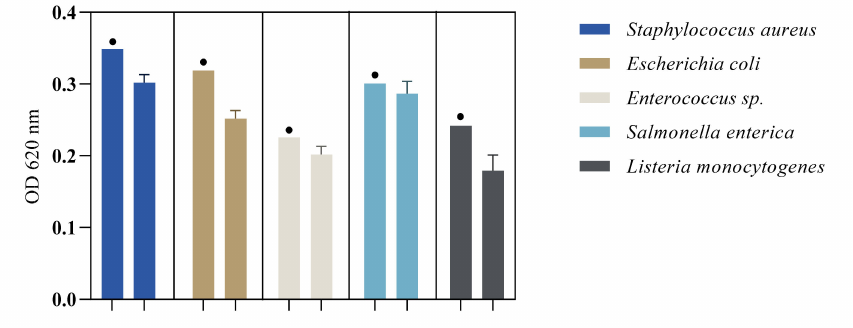
Figure 6. Bacterial recovery rates • = positive control (initial inoculum of 10 5 CFU/mL in saline buffer) ( p <